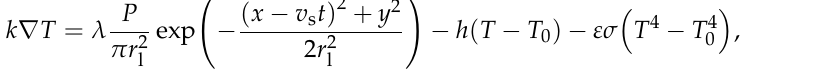
Table 3. Laser process parameters used in the numerical simulation.